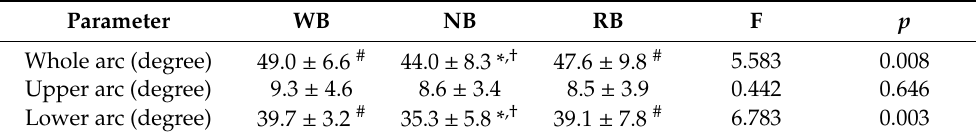
Table 2. Comparison of lumbar spine alignment in each condition.